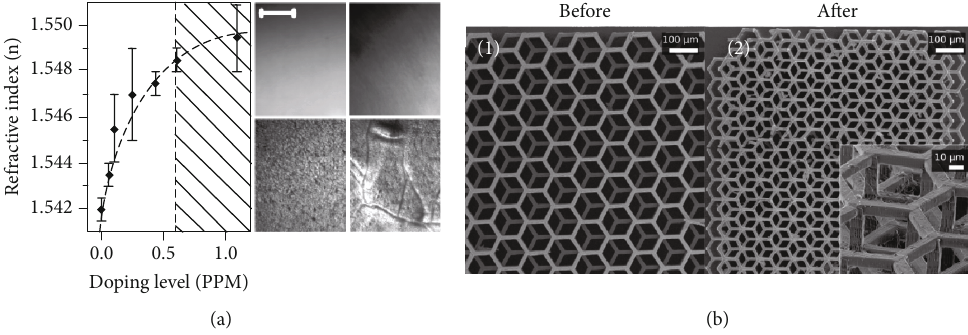
Figure 11: (a) Refractive index change and structure topography of material doped with di ff erent concentration of PbS quantum dots. Substantial change of both is clearly visible. Scale bar: 50 μ m (adopted from [159]). (b) Sca ff old structure made out of hybrid organic- inorganic photopolymer SZ2080 (1) and then modi fi ed into glass-ceramic via thermal postprocessing. Clear downscaling while preserving the shape and structural complexity is evident (Adapted with permission from [166] © The Optical